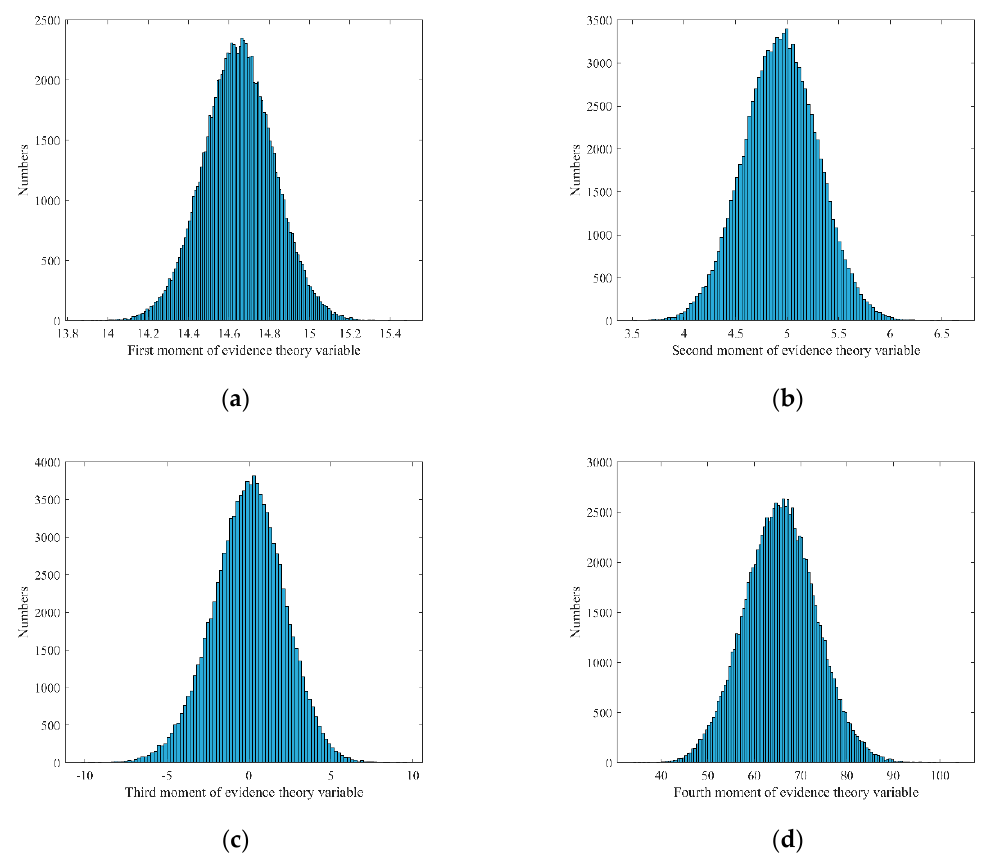
Figure 3. Four moments of the evidence theory variable ( a ) First-order moment (mean); ( b ) second-order moment (variance); ( c ) third-order moment (skewness); ( d ) fourth-order moment (kurtosis).